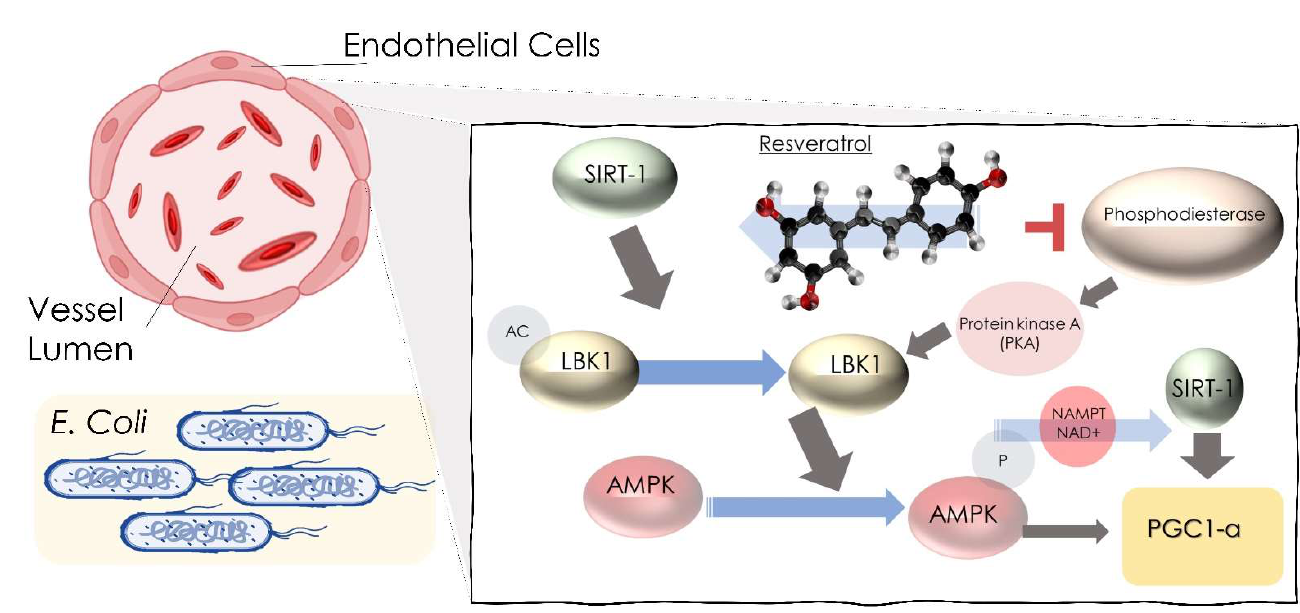
Figure 3. Summary of the pathway correlated to the bacteria infection protective properties of RSV. RSV pathways are able to produce a signals cascade involving Sirtuin 1 [SIRT-1], adenosine monophosphate (AMP)-activated protein Kinase [AMPK] (blue arrow), liver-kinase B1 [LKB1] (grey arrow), and peroxisome proliferator-activated receptor-γ coactivator [PGC-1α].